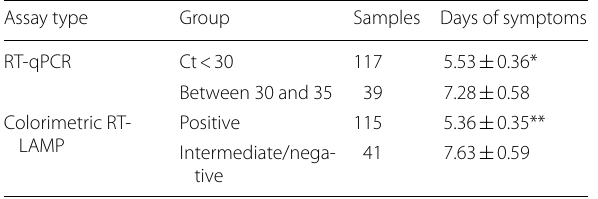
RT-qPCR was divided into Ct < 30 and between 30 and